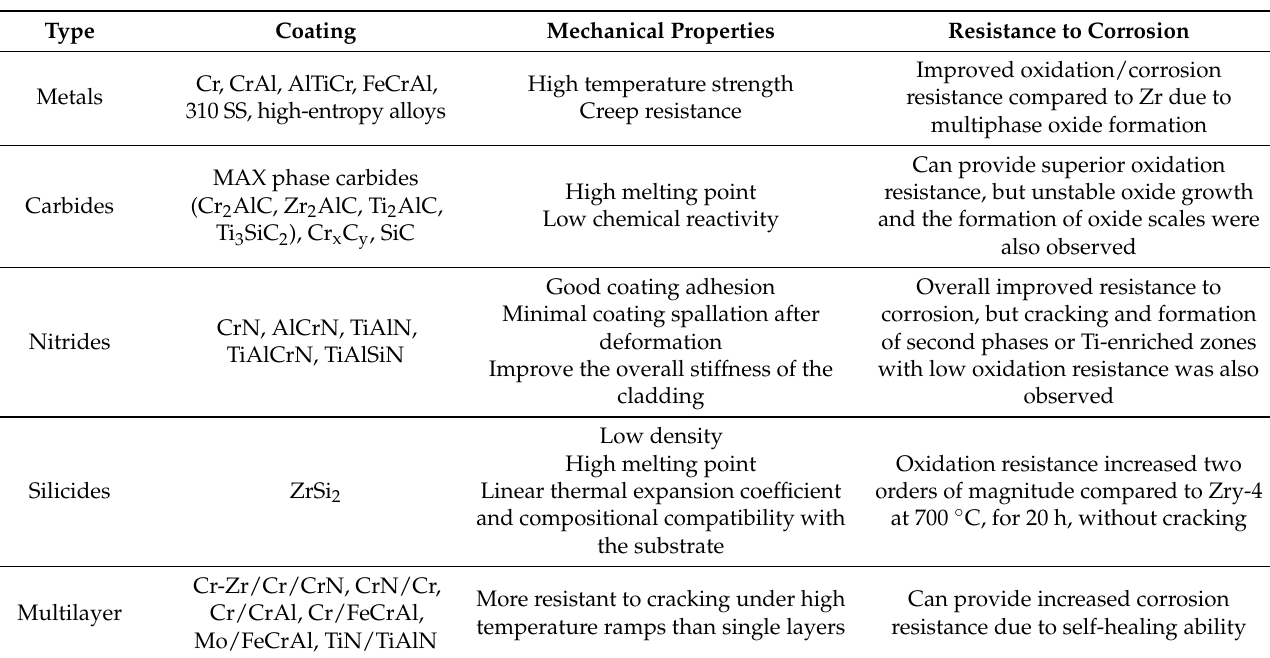
Table 2. Proposed coatings for accident tolerant fuels (ATF)